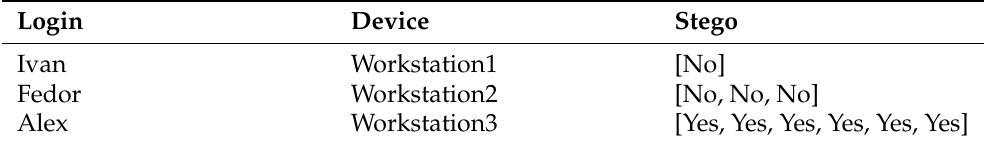
Table 6. Example of query results of the algorithm for Feature